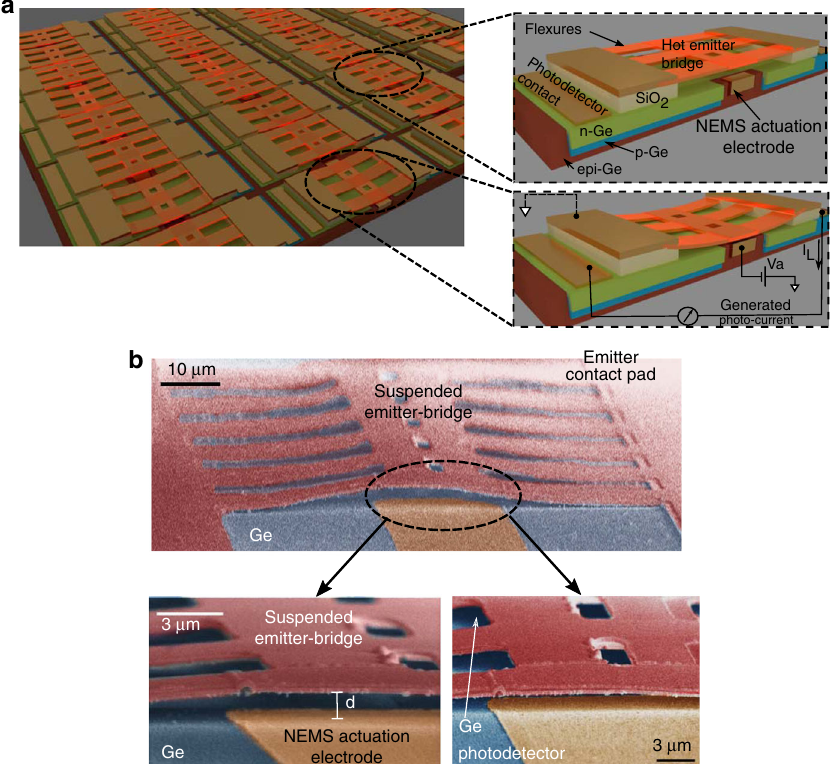
Fig. 1 Near- fi eld thermo-photovoltaic cell. a Schematic of an array of thermo-photovoltaic cells demonstrated here. The platform consists of a nano- electromechanical system (NEMS) integrated with a photodetector cell. The NEMS consists of a suspended bridge (80 × 15 μ m 2 ) made of amorphous silicon (a-Si) anchored on two silicon dioxide (SiO 2 ) pads. The zoomed in schematic shows a single unit cell, where one can see the suspended bridge, the partially underlying actuation electrode and the photodetector region. The silicon substrate over which the cell is fabricated is not shown here. The central region of suspended bridge is brought closer to the underlying photodetector cell through application of actuation potential. The suspended bridge serves as mechanical support for a thin- fi lm metallic thermal emitter, which can be heated to high temperature. The generated electricity from near- fi eld radiative heat is collected at the photodetector terminals. b Scanning electron micrograph of the fabricated structures showing the emitter suspended over the Ge photodetector and NEMS actuation electrode. The holes in the suspended bridge facilitate etching of the sacri fi cial oxide layer during the release